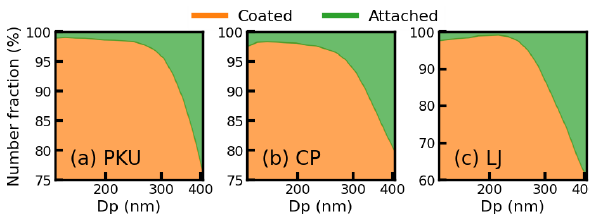
Figure 8. The number fractions of the coated and attached BC un- der different diameters for the (a) PKU, (b) CP, and (c) LJ sites.